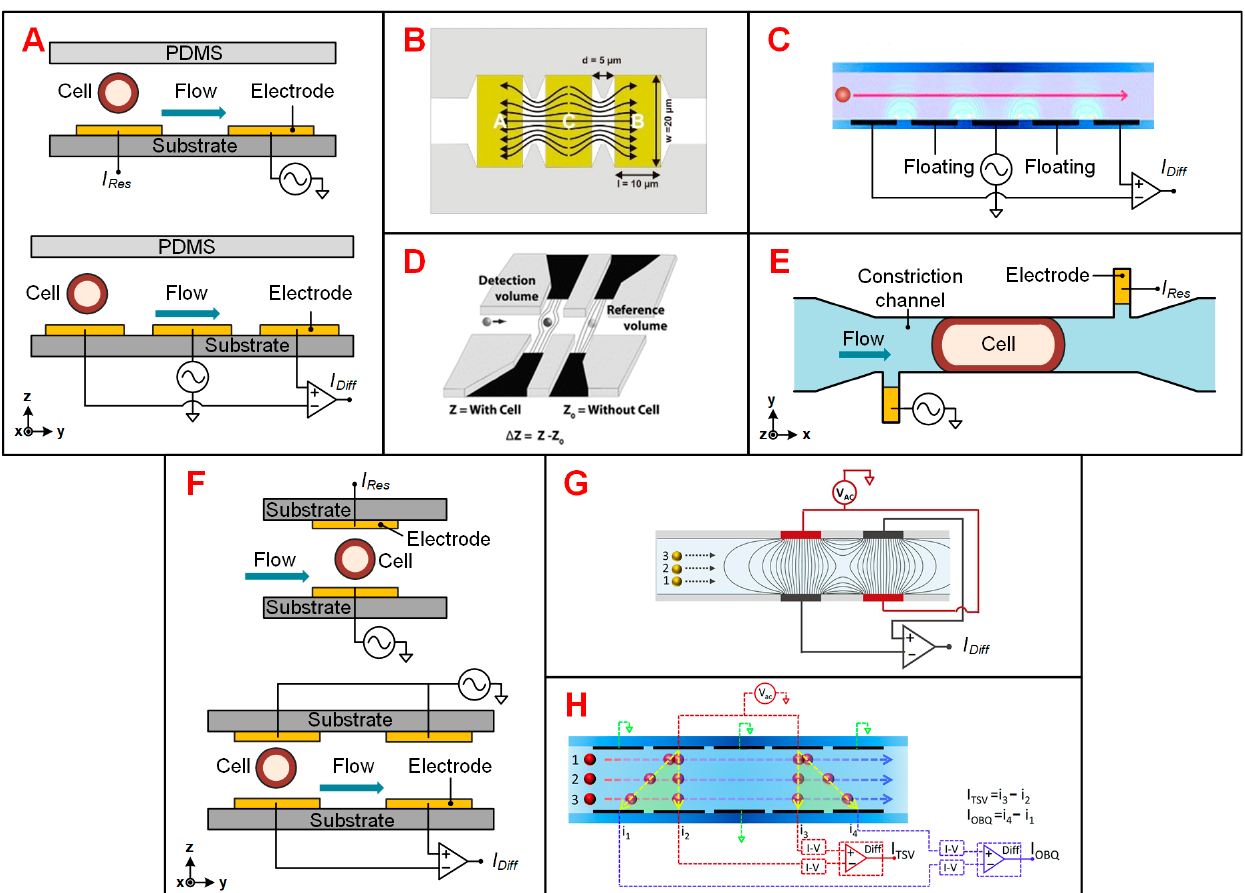
Figure 2. Different designs of IFC devices. ( A ) Schematics of absolute and differential measurement schemes of coplanar electrode configuration. I Res refers to response current and I Diff refers to differential current. ( B ) Coplanar electrodes with larger electrode area exposed to the medium. Reproduced from [39] with the permission from MDPI. ( C ) Coplanar electrodes with two extra floating electrodes. Reproduced from [41] with the permission from Royal Society of Chemistry. ( D ) Liquid electrodes. Reproduced from [42] with the permission from Royal Society of Chemistry. ( E ) Asymmetrical liquid electrodes with the constriction channel for cell flowing [43]. ( F ) Schematics of absolute and differential measurement schemes of facing electrode configuration. ( G ) Facing electrodes with asymmetric wiring scheme. Reproduced from [44] with the permission from Elsevier. ( H ) Five pairs of facing electrodes. Reproduced from [45] with the permission from Royal Society of Chemistry.